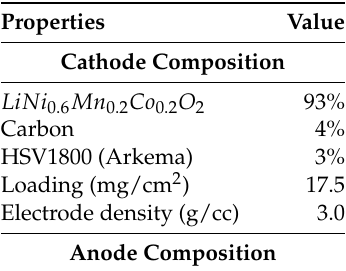
Table 2. Cell specifications of tested 1360-mAh NMC622/Si-alloy pouch